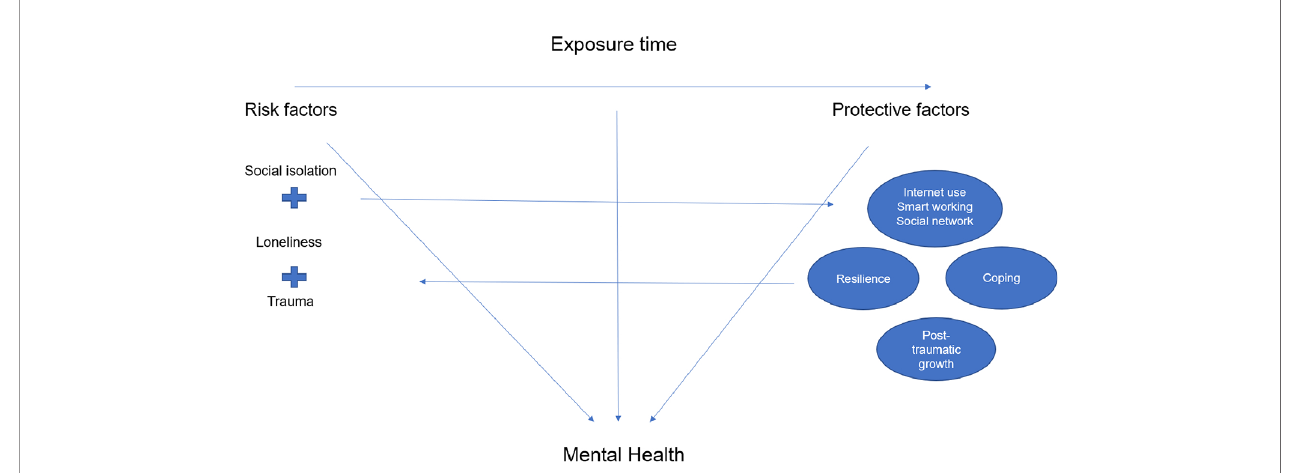
FIGURE 1 | Determinants of mental health during the